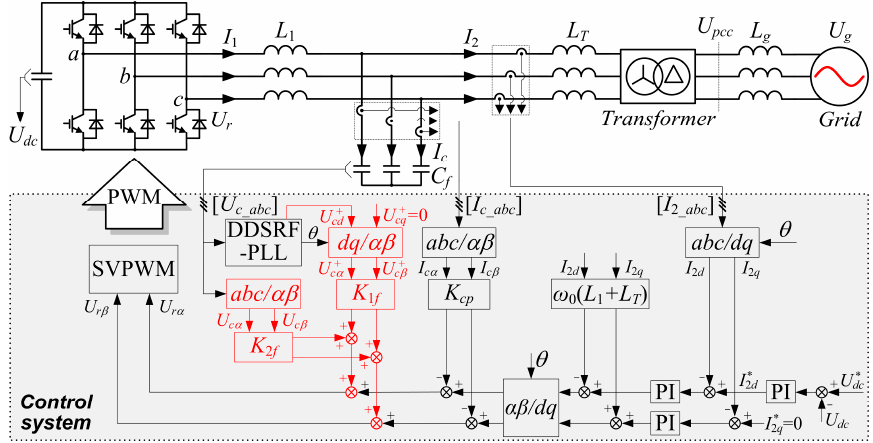
Figure 6. Control block of three-phase LCL-type grid-connected converter with proposed method.